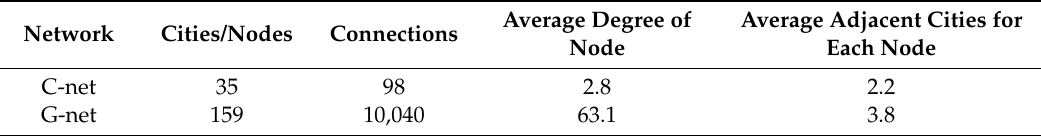
Figure 2. The two topological models for railway nets: ( a ) space L model; and ( b ) space P model. Table 2. The number of nodes and edges for the train line